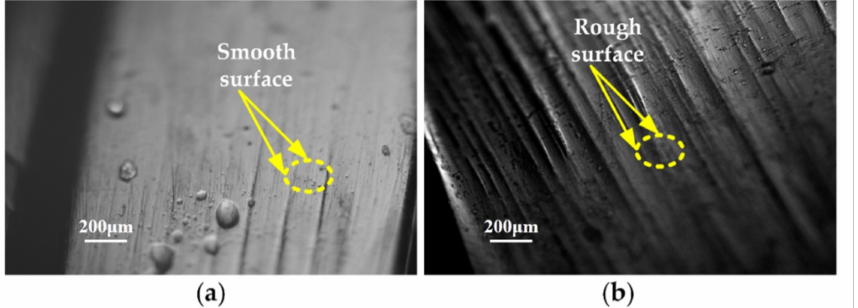
Figure 2. Microscopic view of the needle surface: ( a ) surface morphologies of the coated needle; ( b ) surface morphologies of the uncoated